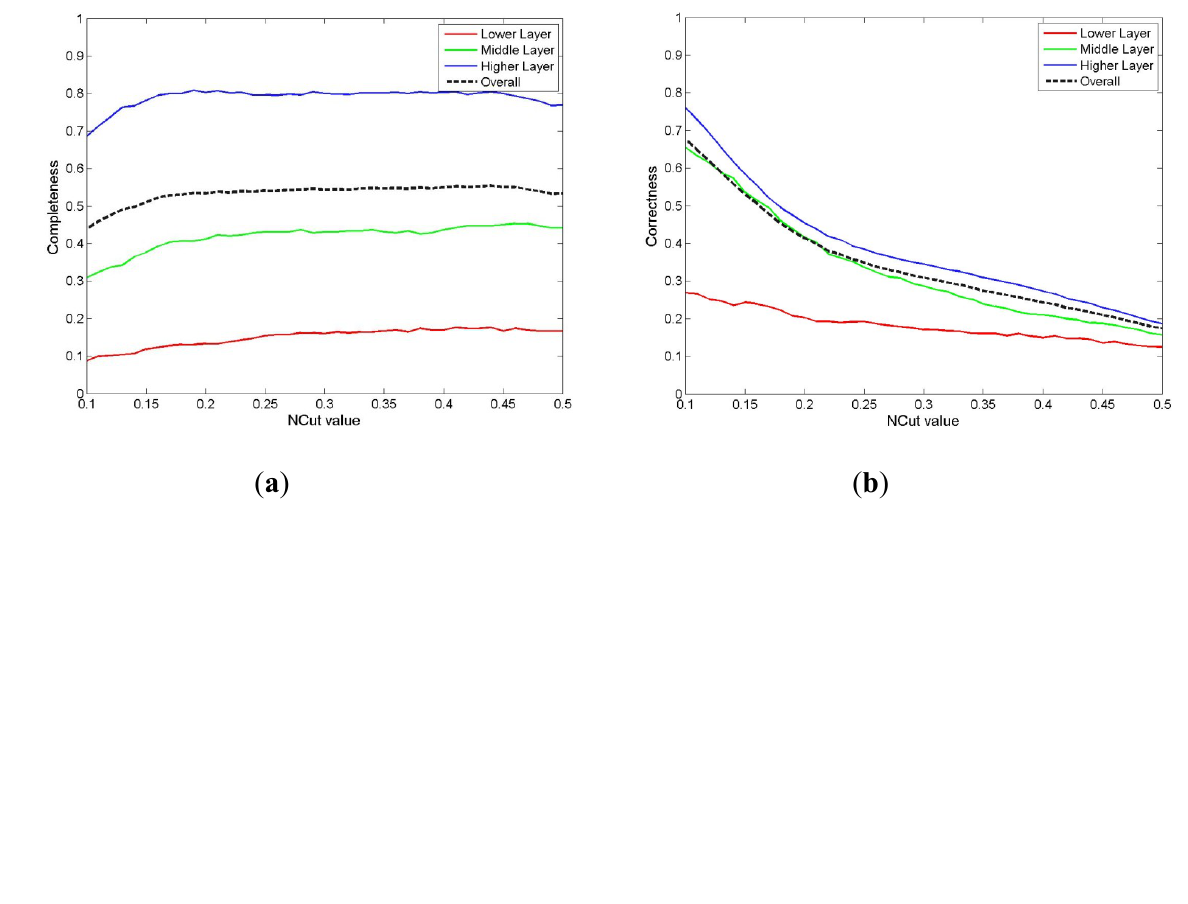
Figure 6. Sensitivity analysis with respect to the parameter NCut Site I acquired under leaf-on condition; ( a ) Completeness; ( b ) Correctness; colored lines indicate the forest